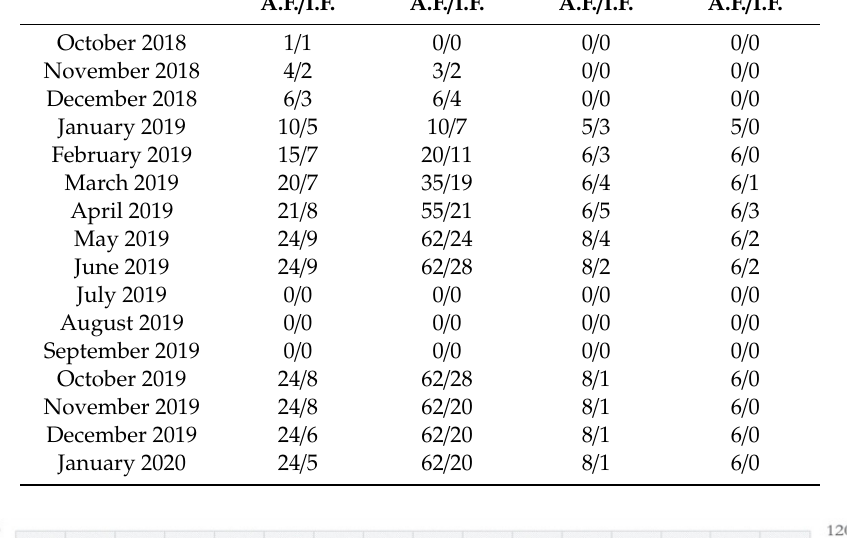
Table 3. Number of analyzed farms (A.F.) and number of detected infected farms (I.F.) per month in the different provinces investigated.